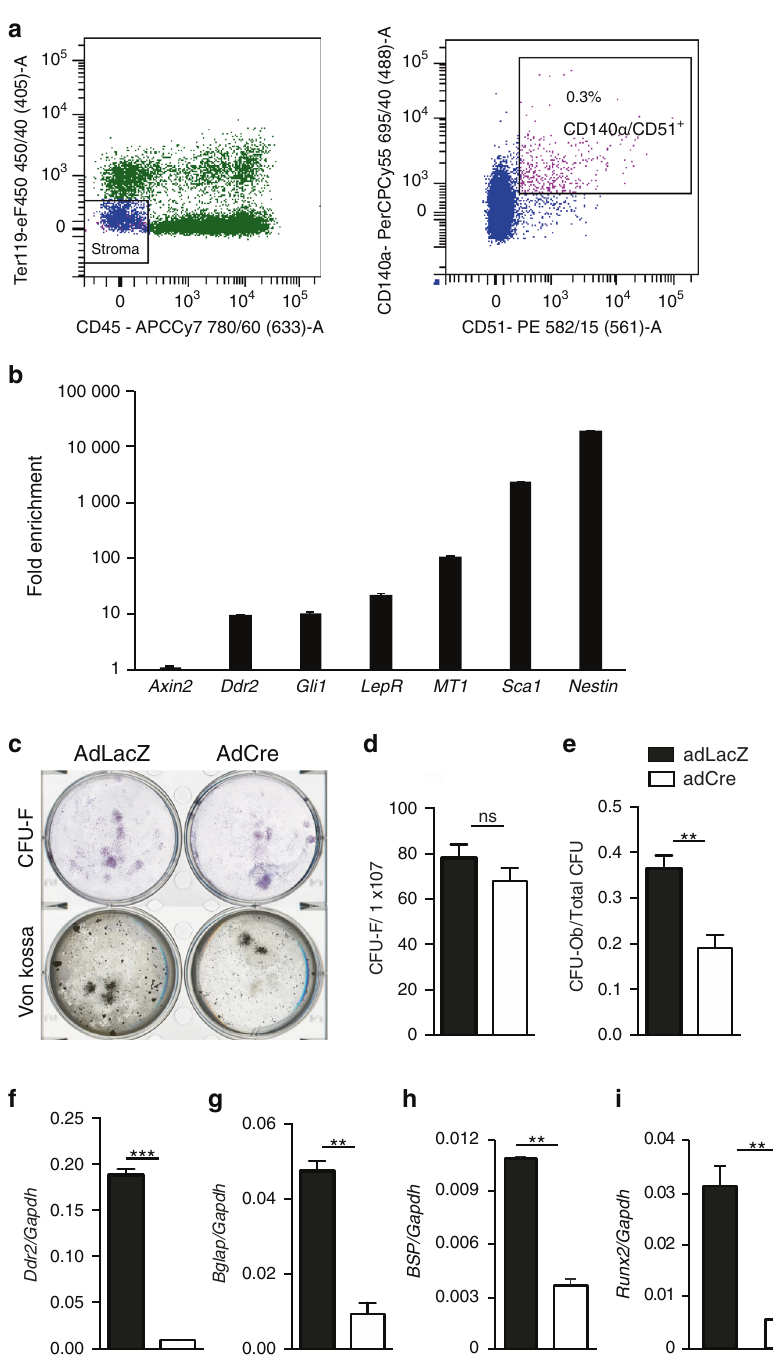
Fig. 9 Requirement for Ddr2 in osteoblast differentiation of puri fi ed marrow-derived skeletal progenitors. a Flow cytometry analysis and isolation of CD140 α /CD51 + cells from Ddr2 fl / fl mice. Boxed region (right) shows percentage of BM stem/progenitor cells. b Fold enrichment of Ddr2 and stem cell marker mRNAs in CD140 α /CD51 + cells. c – e Colony forming unit- fi broblast (CFU-F) and CFU-osteoblasts (CFU-Ob) assays showing Ddr2 de fi ciency inhibits CFU-Ob. c Representative images of CFU-F and CFU-Ob. d CFU-F. e CFU-Ob. f – i Gene expression analysis of CD140 α /CD51 + bone marrow cells treated with AdLacz or AdCre and grown in osteogenic medium. Closed bars, AdLacZ (control); open bars, AdCre. Unpaired t -test * P < 0.05, ** P < 0.01; *** P < 0.001; **** P < 0.000 1; ns Not signi fi development and in adults. 37 Gli1 + cells labeled during embryonic in progenitor populations and chondrocytes. The mice selected for these studies were previously shown to have strong Cre activity in stages give rise to most osteoblasts, chondrocytes, marrow skeletal progenitors ( Gli1-Cre ERT ), chondrocytes ( Col2a1-Cre ) or adipocytes and stroma. A separate pool of mesenchymal stem cell-like Gli1 + cells were identi fi ed beneath the growth plate mature osteoblasts/osteocytes ( Ocn-Cre ). For Gli1-Cre ERT , lineage tracing previously showed that cells marked with this Cre are a (termed “ metaphyseal mesenchymal progenitors ” ) and shown to major source of skeletal progenitors during embryonic be essential for trabecular bone formation in young mice. We